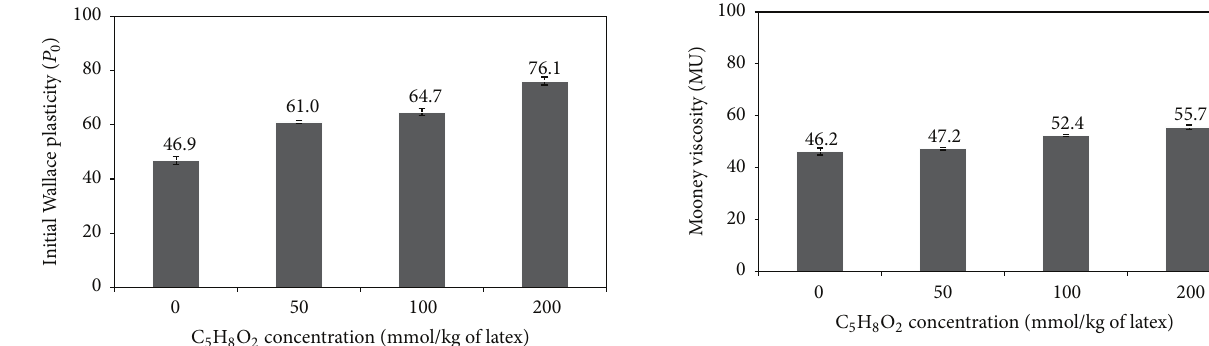
Figure 5: Initial Wallace plasticity ( 𝑃 0 ) of NR obtained from the fresh NR latex treated with different concentrations of C 5 H 8 O 2 .